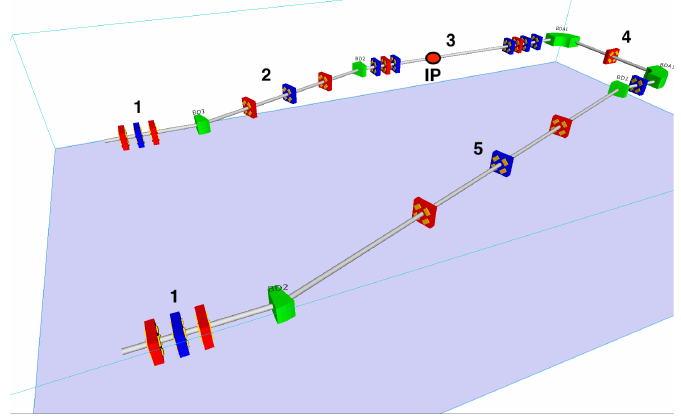
Figure 5. Scheme of the magnetic elements of a single BriXs beam line.